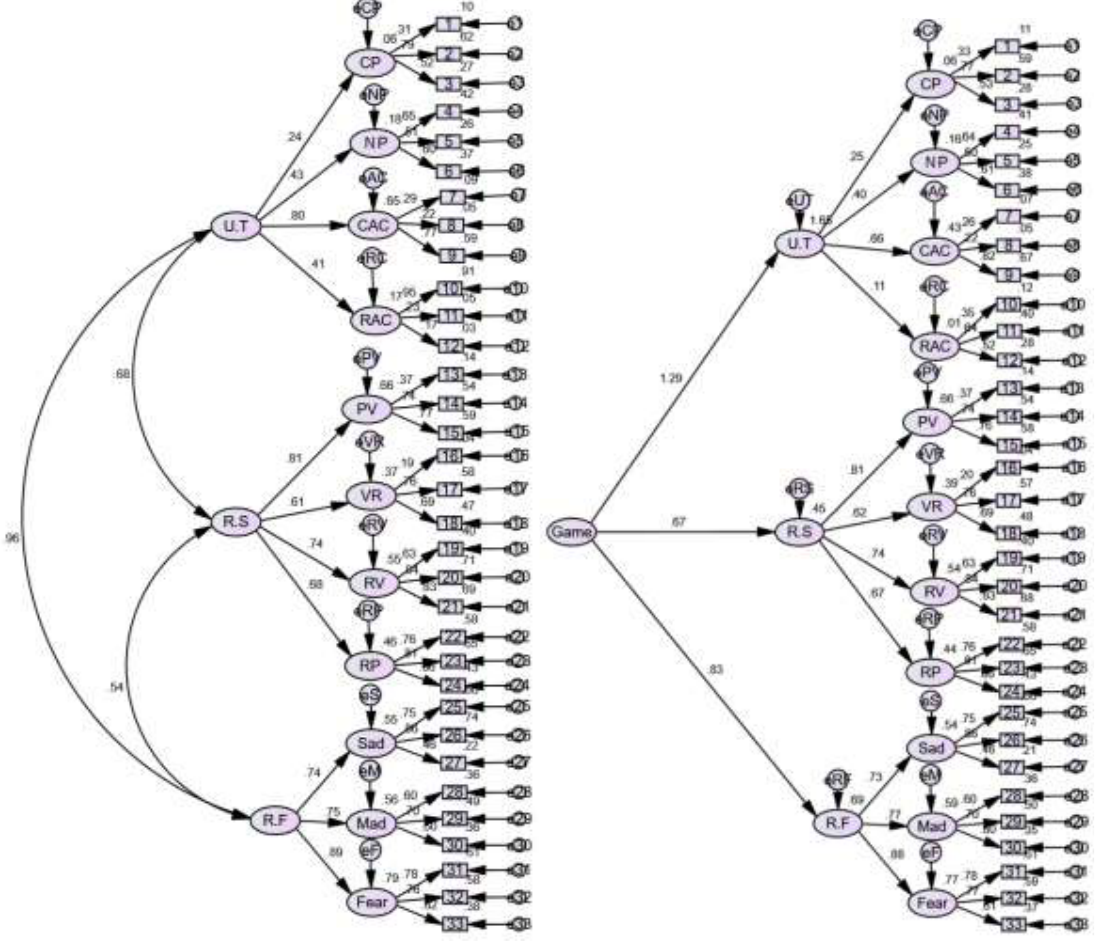
Figure 2: Models of potential